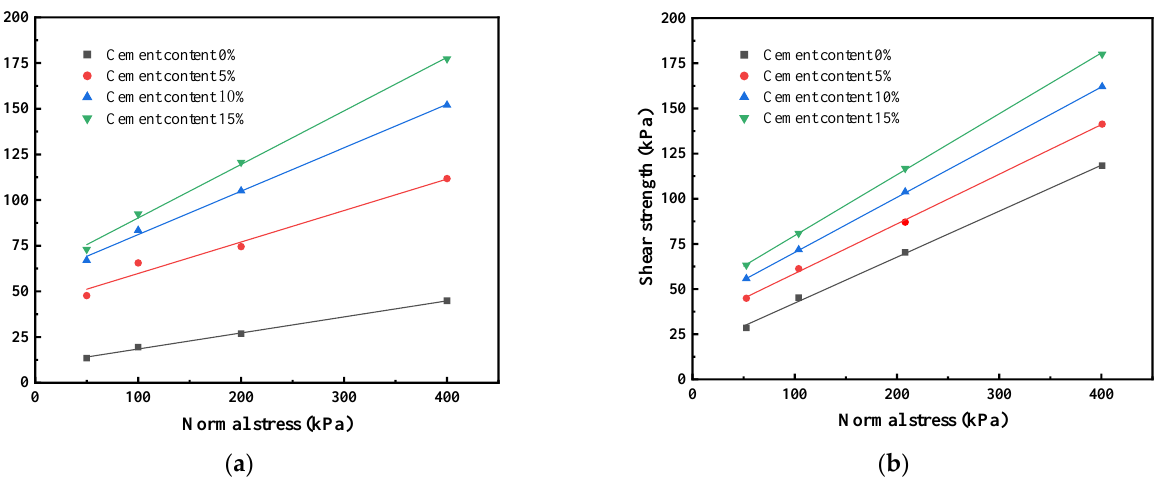
Figure 7. Shear strength of soil around the permeation grouting piles under different cement con- tent. ( a ) Muddy clay. ( b ) Silty clay.